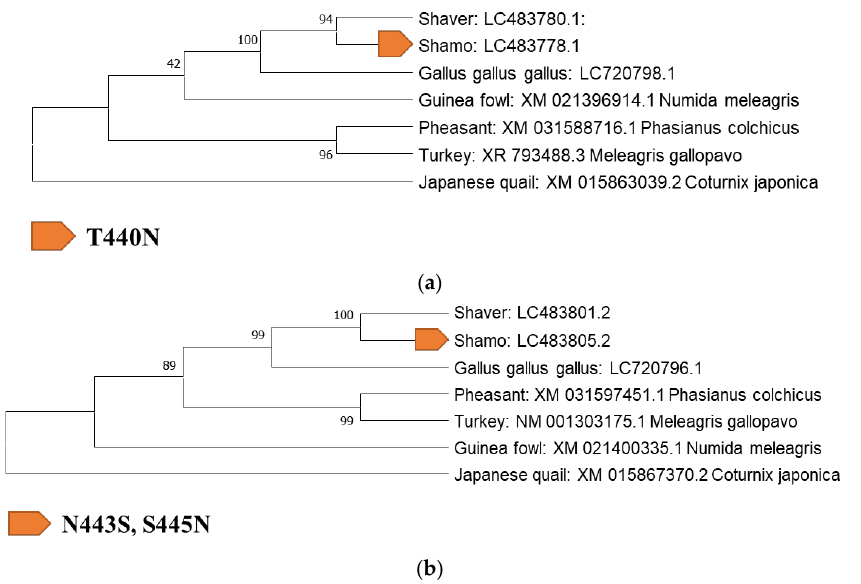
Figure 3. Phylogenetic analysis of the adrenergic receptor (ADR) genes ADR α 1D ( a ) and ADR β 1 ( b ).